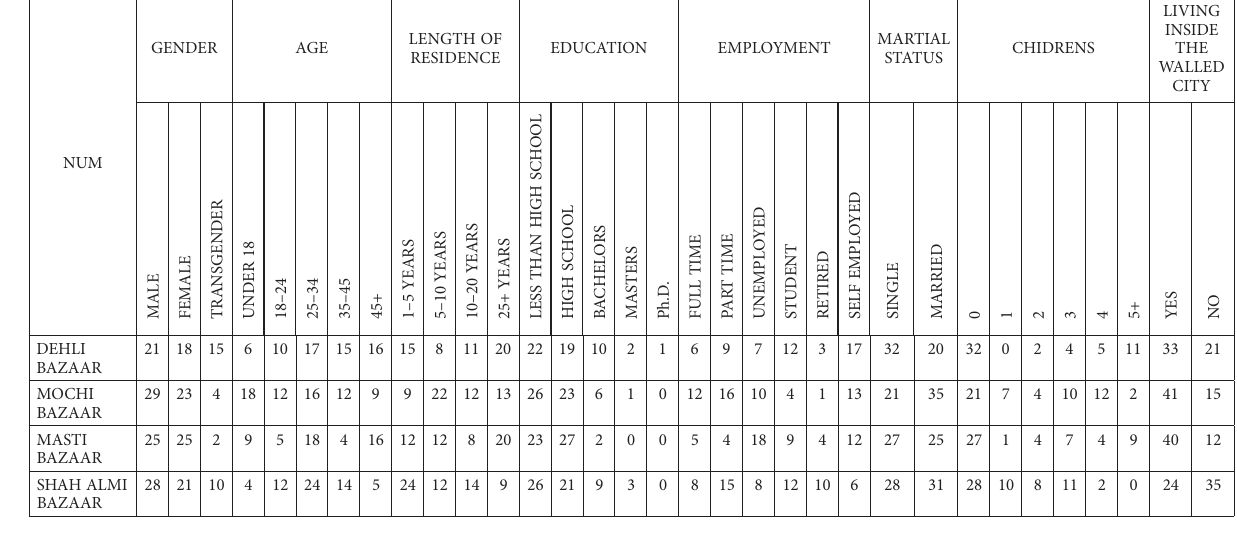
Table 3. The user analysis